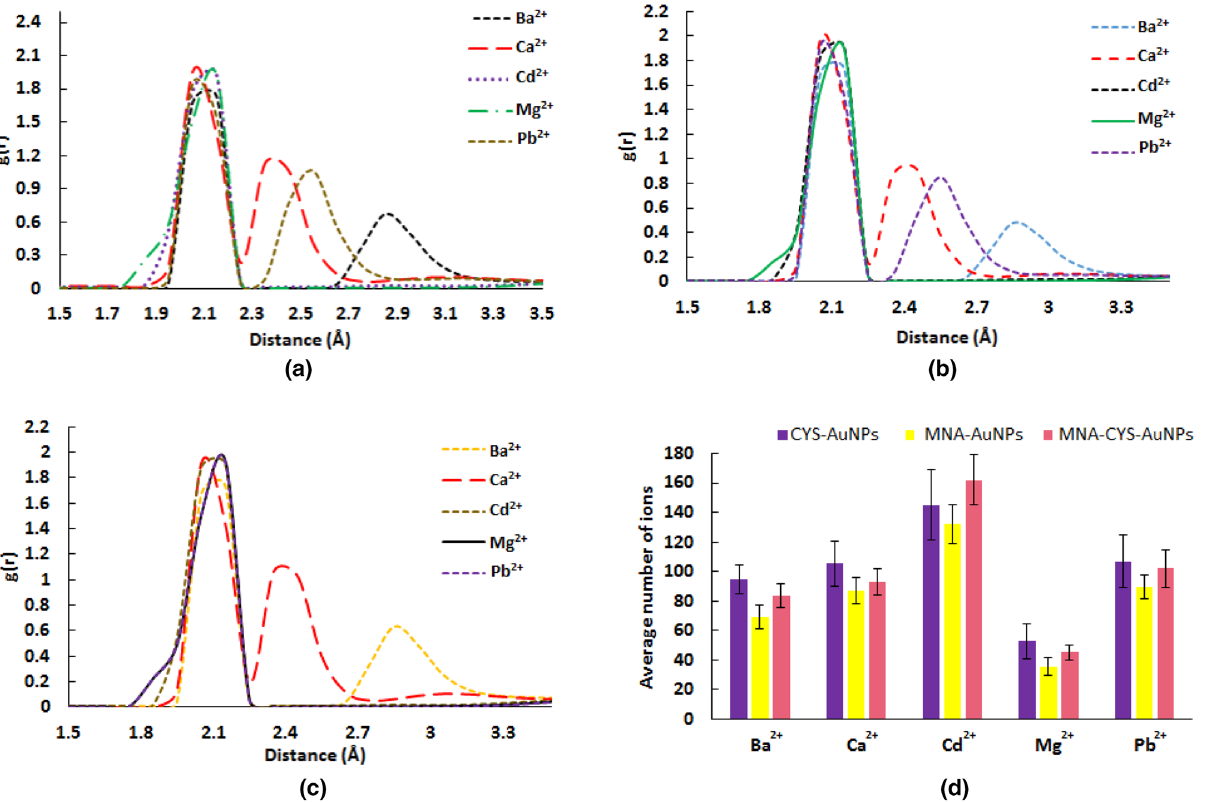
Figure 7. The calculated RDF plots of the O …. metal ion (O atoms of CYS or MNA) pairs for the CYS-AuNPs ( a ), MNA-AuNPs ( b ) and MNA-CYS-AuNPs ( c ) and the calculated average number of different ions ( d ) around the functionalized AuNPs. The average values were calculated during 50 ns MD simulations and the error bars show the calculated standard deviation of the corresponding